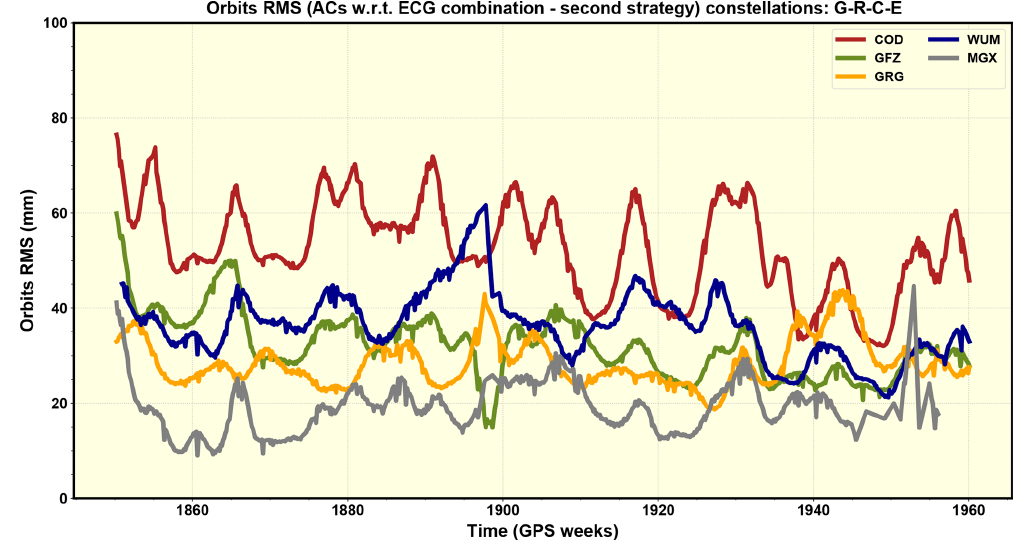
Figure 6. RMS with respect to the individual ACs’ orbits using all constellations and the ECG combination result using the Helmert-based strategy